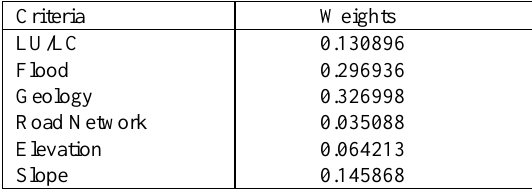
Table 3: Priority vectors from weighted decision